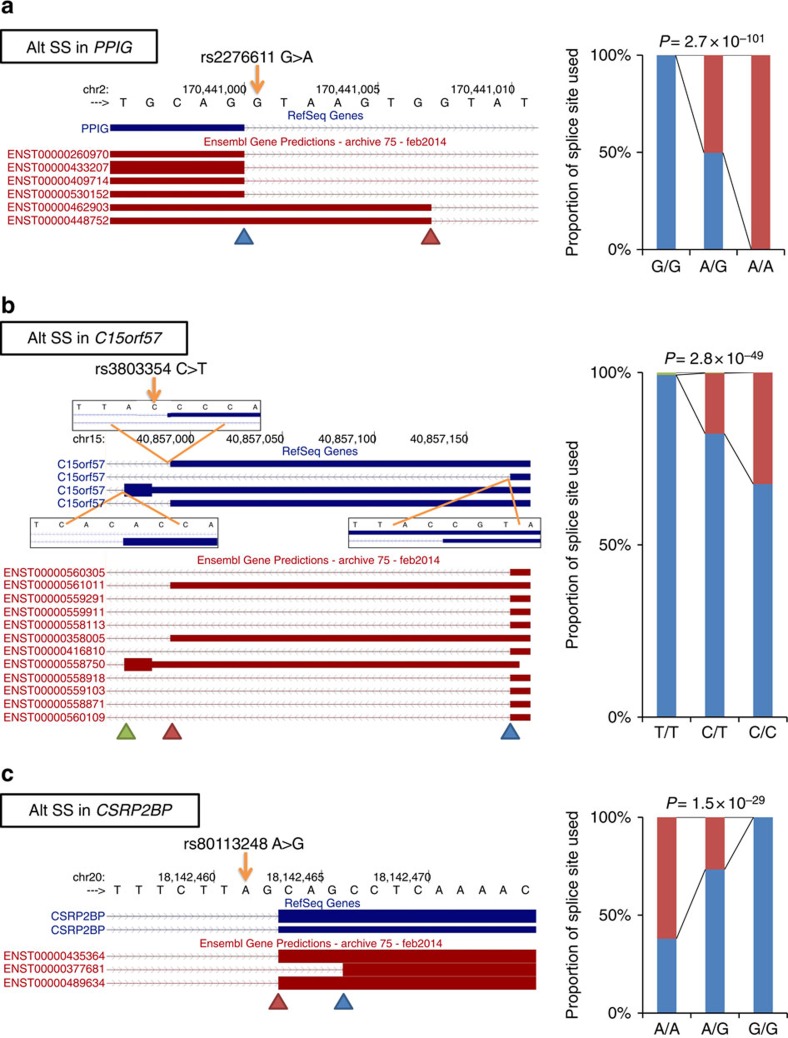
sQTL SNPs at canonical splice sites of genes with known transcript isoforms.sQTL SNPs at the canonical splice sites of PPIG (a), C15orf57 (b) and CSRP2BP (c) controlling alternative usage of splice sites. Schematic of transcript isoforms at each locus (RefSeq Genes and Ensembl Gene Predictions tracks from the UCSC Genome Browser (https://genome.ucsc.edu/) with the genomic sequences and coordinates) are shown in the left panels. Orange arrows indicate the positions of sQTL SNPs. Arrowheads indicate alternative splice sites. In b, detailed sequences around three differently used splice sites (chr15: 40,856,965, 40,856,990 and 40,857,175) are shown in magnified view. Proportions of alternative splice sites used are shown in the right panels. The averages among the carriers of each genotype are shown as stacked bars. The colours of stacked bars (blue, red and green) correspond to the alternative splice sites (arrowheads) in the left panels. Double-corrected P-values (see Methods) are indicated above the bars.